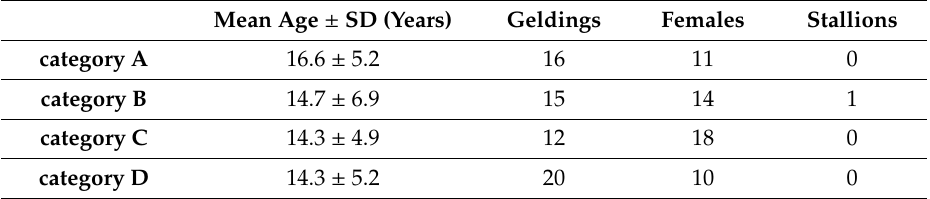
Table 1. Summary of the ages and sex of horses included in the di ff erent housing categories.